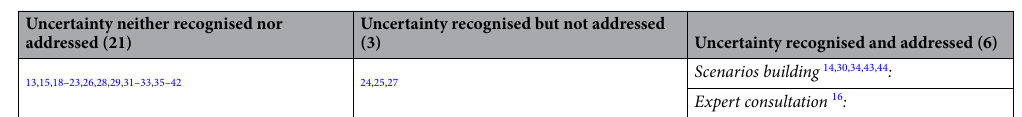
Uncertainty neither recognised nor addressed